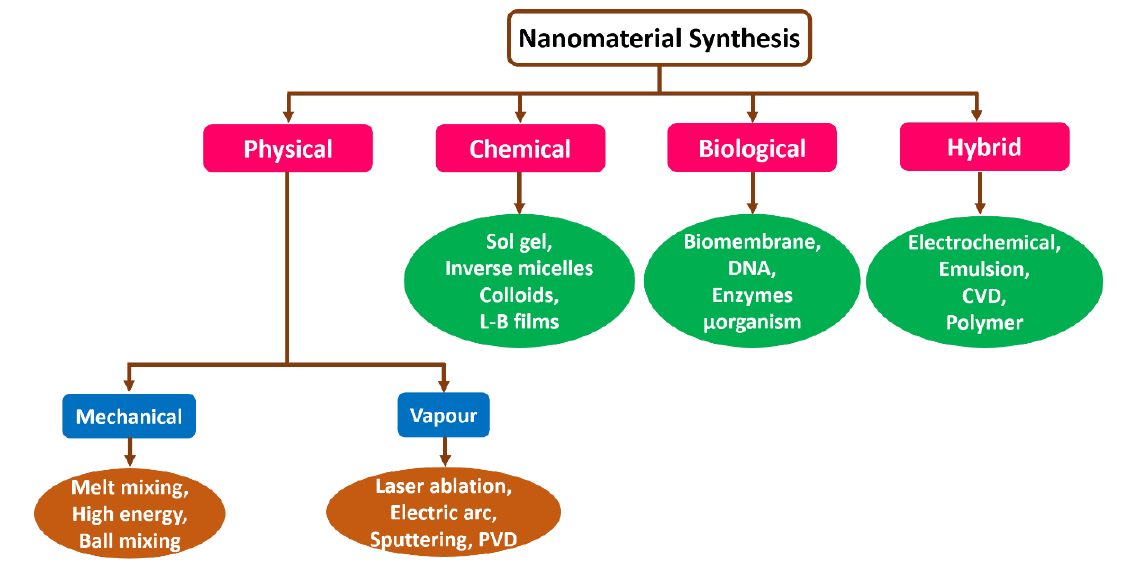
Figure 3. Schematic representation of several techniques that are used for the synthesis of nano- materials.